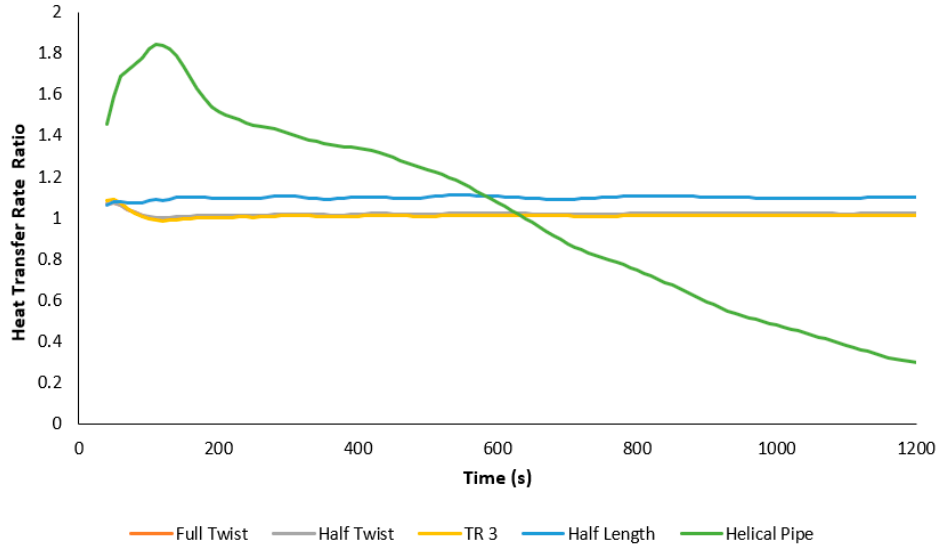
Figure 8. Heat transfer rate of the various configurations relative to the straight pipe (note: the full twist, half twist and TR3 lines approximately overlap and some of the lines are not visible).